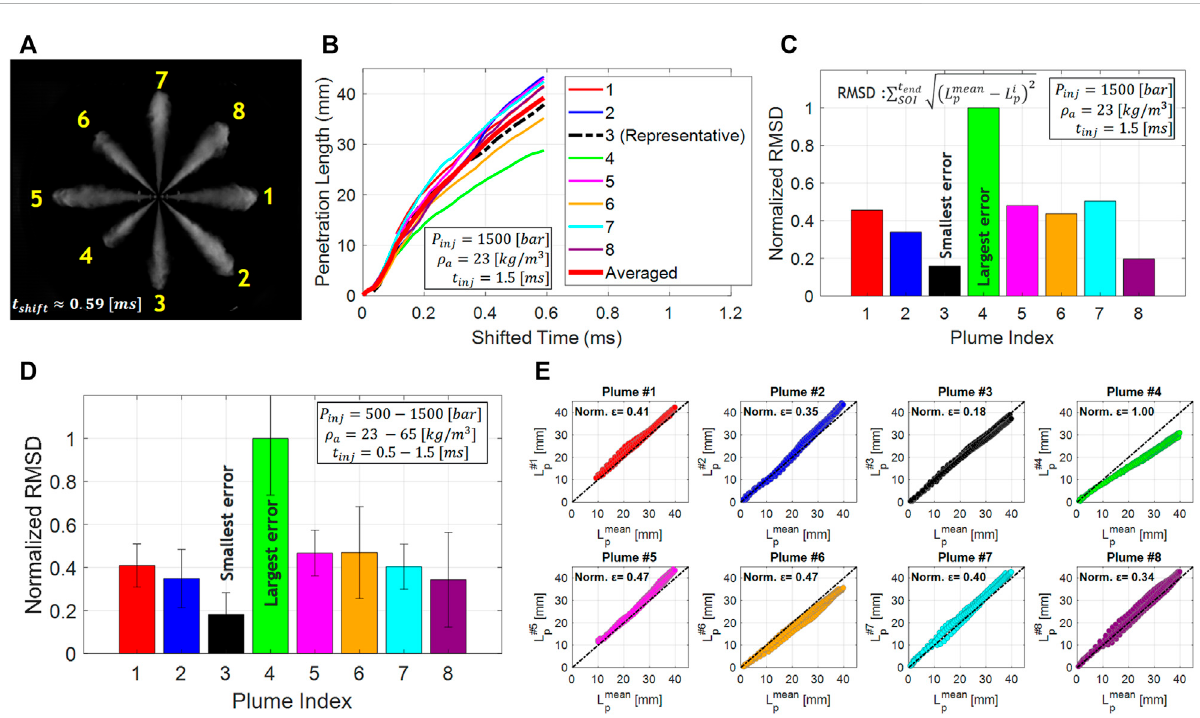
FIGURE 3 (A) Visualized spray penetration at a shifted time t shift (cid:1) 0 . 59 [ ms ] and (B) comparison of penetration lengths of each plume with the averaged plume (red thick solid). A black-dashed line denotes the representative plume with minimum deviation against the averaged plume. (C) Normalized root-mean-square deviation (RMSD) as a function of plume index from the selected operating condition and (D) summed RMSD between each plume against the averaged plume. (E) Scatter plots of the spray penetration of each plume ( L i p ) against the averaged plume ( L mean p ) with normalized deviation ( ε ), evaluated in wide-ranging operating